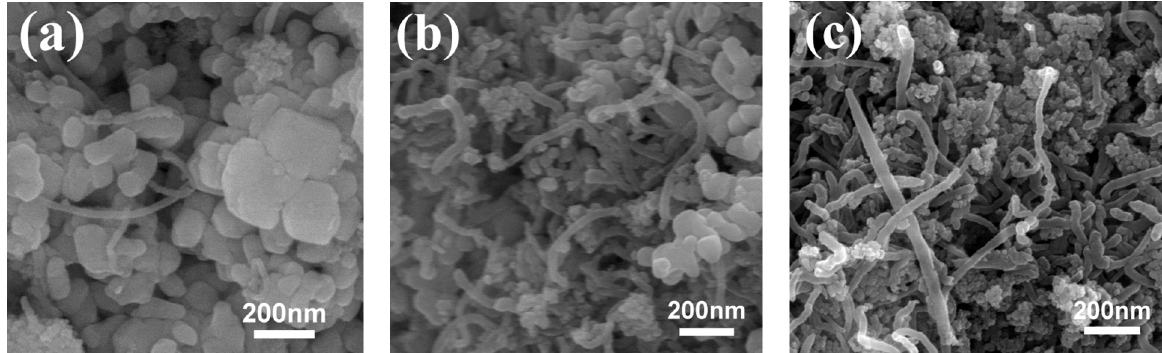
Figure 3. SEM images of BZT@MWCNTs nanoparticles with different MWCNTs contents: ( a ) 0.25 vol%, ( b ) 0.50 vol%, and ( c ) 1.00 vol%.